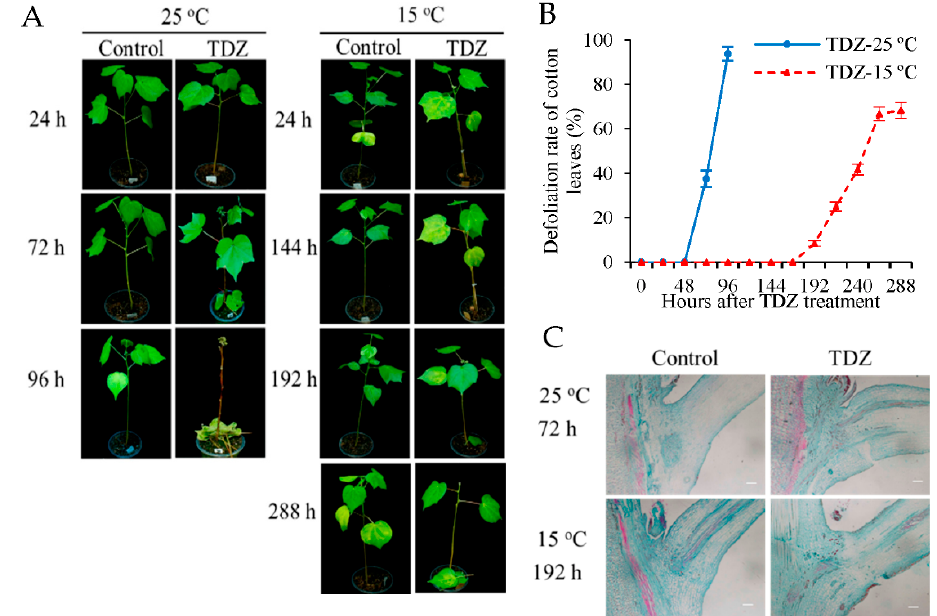
Figure 1. Effects of low temperatures on the abscission of cotton leaves treated with TDZ under different temperatures. ( A ) Representative images of cotton plants treated with thidiazuron (TDZ) or water (control) taken at 24, 72, and 96 h after treatment under 25 °C, and at 24, 144, 192, and 288 h after treatment under 15 °C; ( B ) defoliation rate (%) of cotton leaves at different time points after treatment. Error bars represent the SD of three biological replicates; ( C ) paraffin section observation of cotton AZs at 72 h after treatment under 25 °C and at 192 h after treatment under 15 °C. Scale bars are 200 µm. Cotton seedlings with the fifth true leaf fully expanded were used in the experiments.